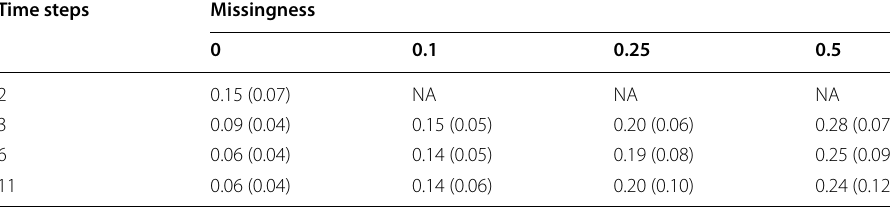
Median (IQR) of RMSE for model parameter recovery by proportion of missing data and number of time steps used for estimation